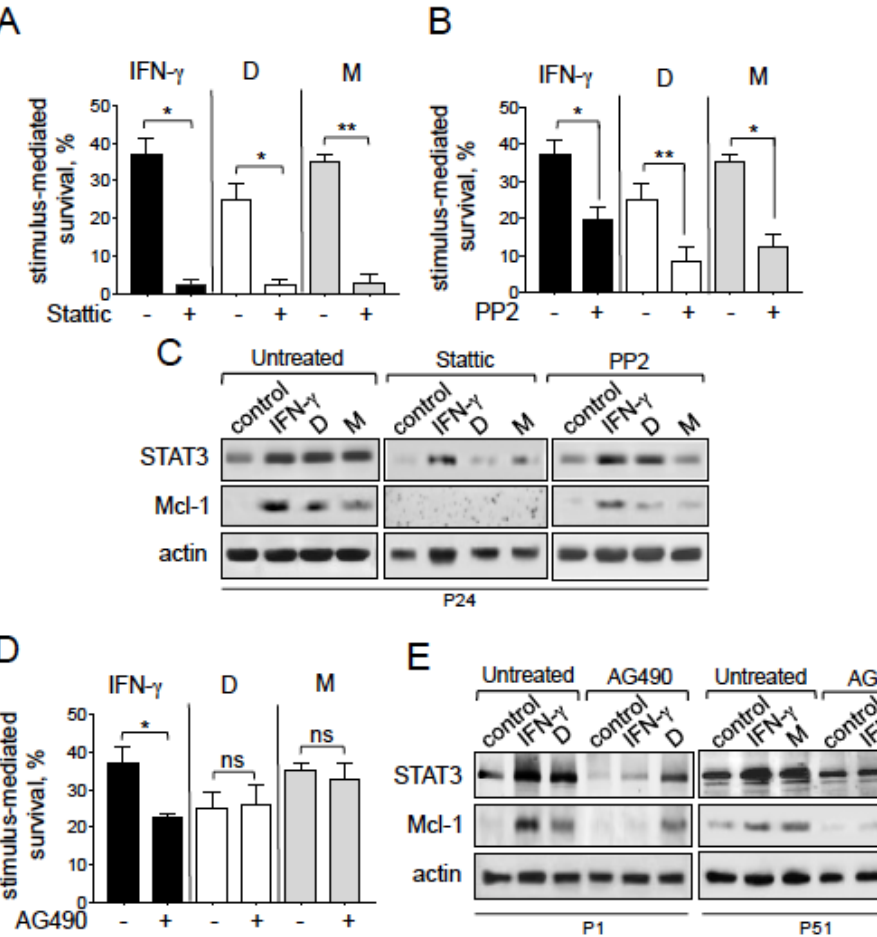
Figure 7. Exogenous NGAL induces CLL cell survival through the Src/STAT3/Mcl-1 signaling pathways. ( A – C ) CLL cells were cultured for 24 h in the presence or absence of NGAL dimers or monomers (100 nM) or IFN-γ (1000 U/mL) after a 15 min pretreatment with ( A ) 5 μM STAT3 inhibitor, ( B ) 10 μM PP2 (an Src family kinase inhibitor), or ( D ) 10 μM AG490 (a JAK2 inhibitor); after which